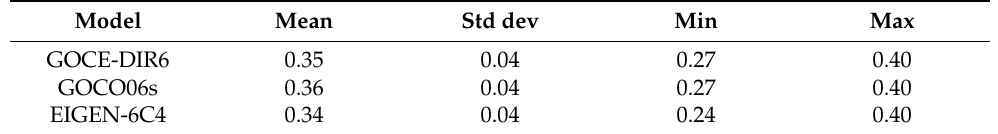
Table 4. Assessment of the accuracy, in meters, of the subsequent quasigeoid models at the points of the ASG-EUPOS network and Kronstadt86 vertical system.